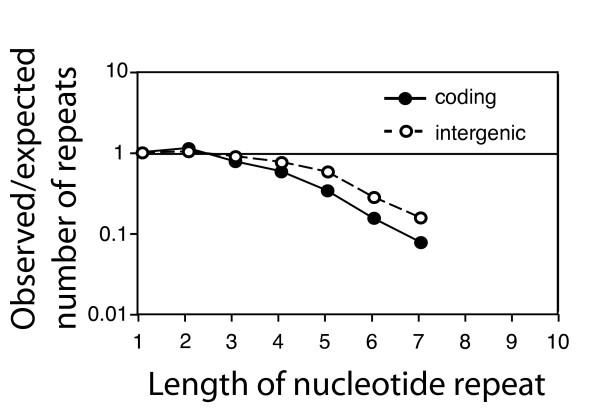
Mononucleotide repeats are less frequent in coding regions than in intergenic regions in the genome of M. tuberculosis. The figure shows the ratio between total number of observed and expected mononucleotide repeats in coding (filled circles and solid line) and intergenic regions (open circles and dashed line). The expected values have been calculated under the null model that nucleotides are randomly distributed in each of these two compartments, and occur at the frequencies observed in each compartment. For repeats of length three to six nucleotides, the under-representation of mononucleotide repeats is significantly stronger in coding regions than in intergenic regions (at p < 0.0001, chi square test).